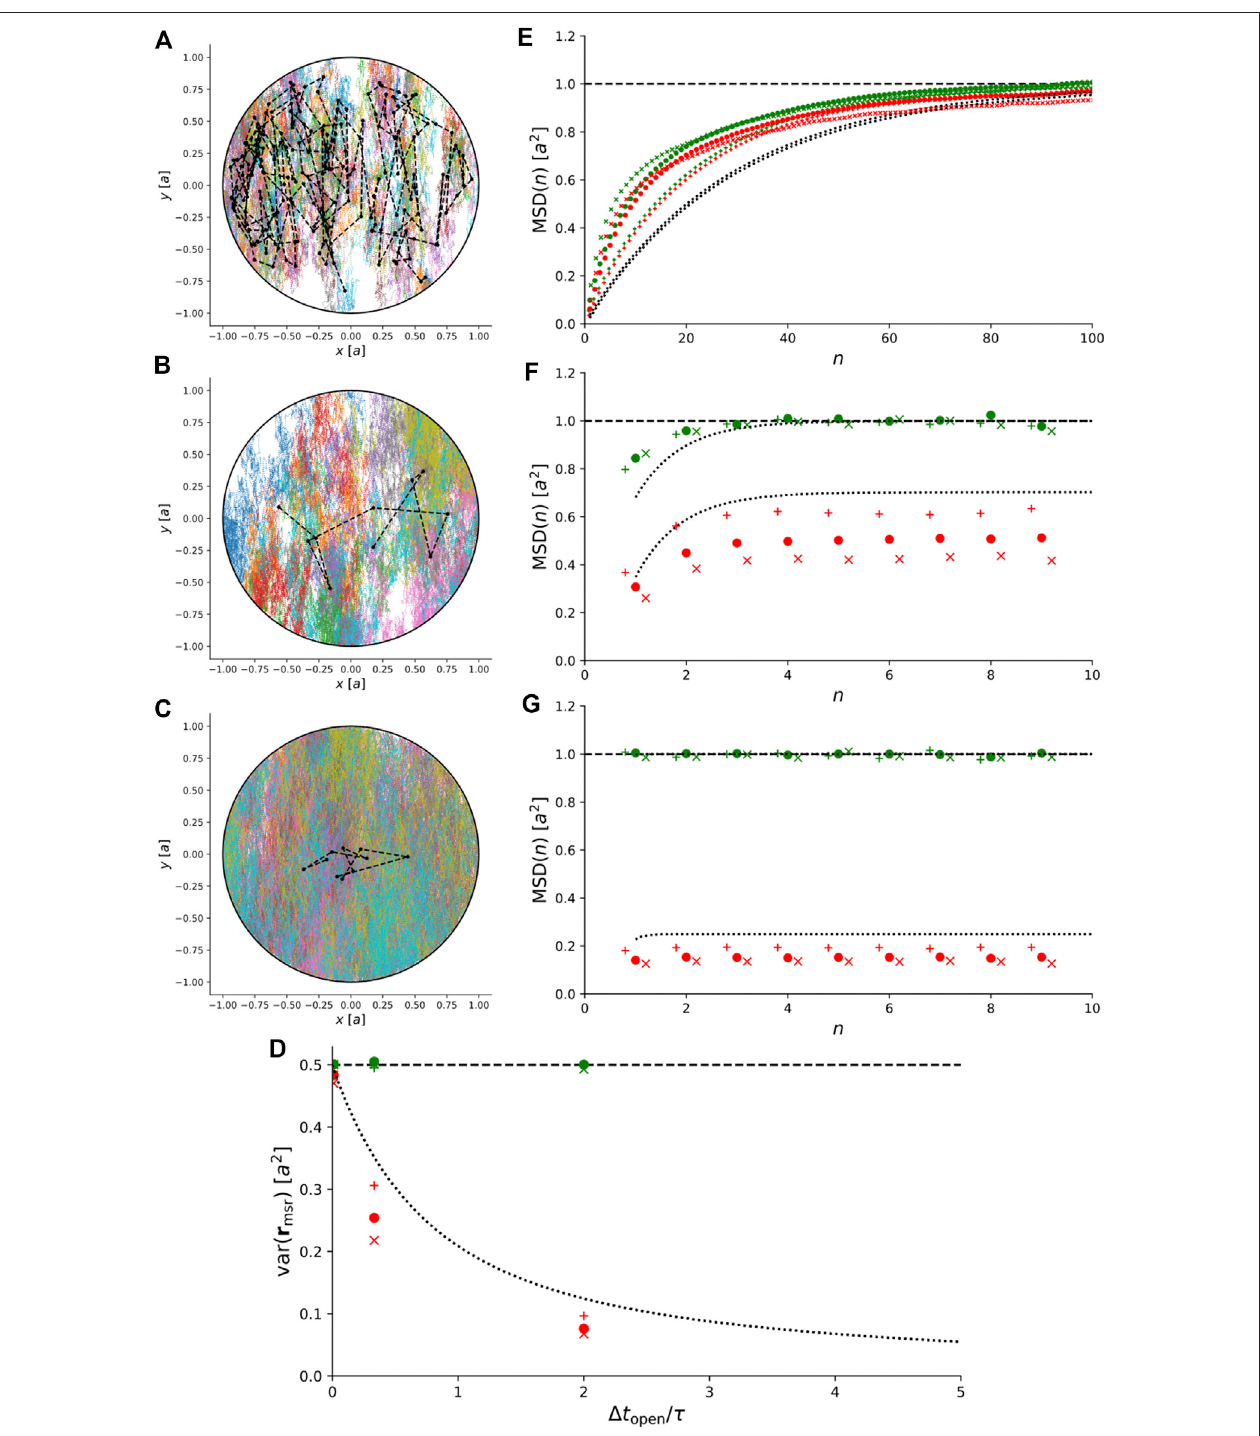
FIGURE 6 | Simulations of 2D anisotropic Brownian motion con fi ned to a circular domain with radius a . (A) – (C) Simulated trajectories for Δ t / τ (cid:2) 0.01, 0.33, and 2, respectively, with Δ t (cid:2) Δ t open , τ (cid:2) a 2 / D x , and D y / D x (cid:2) 10. The measured positions including the effect of motion blur are indicated (black dots connected by dashed lines).Theunderlyingpositionsvisitedbytheparticleduringeachframeinthetime-lapsemovieareshownwithdifferentcolorforeachframe,plottedontopofeachother with the latest frame on top. (D) Variance for the same values of the ratio Δ t / τ as in panels (A) – (C) . Plusses are for D y / D x (cid:2) 2, dots for D y / D x (cid:2) 5, and crosses for D y / D x (cid:2) 10. Color: measured positions excluding (green) and including (red) the effect of motion blur. Dotted curve: the exact result for the variance for isotropic